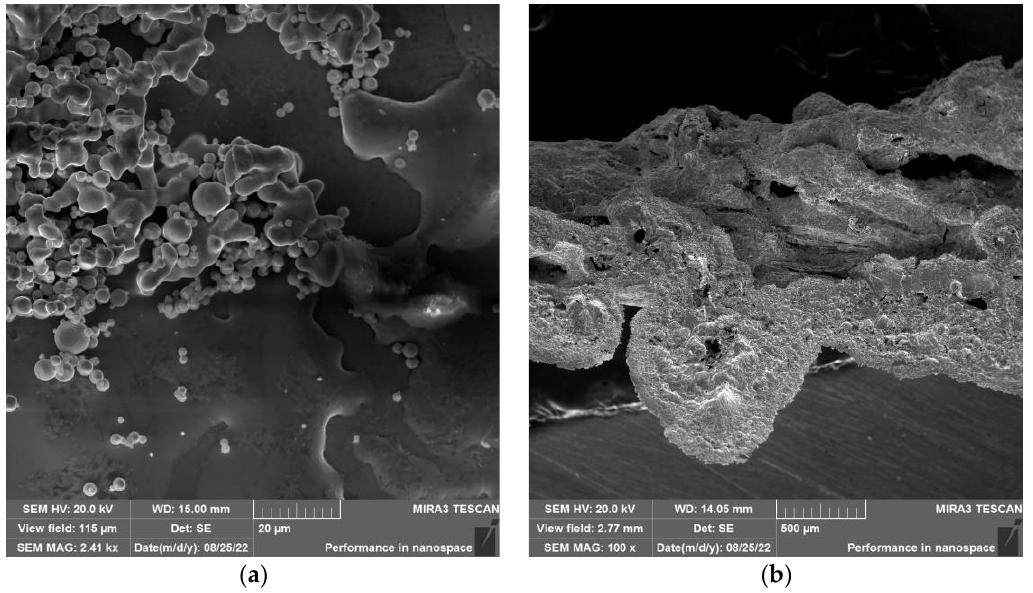
Figure 13. Morphology of ( a ) zinc drop product and ( b ) the residue after evaporation by 800 °C. The result of SEM analysis of the zinc product is shown in Figure 13a, where the individual and connected spherical particles can be observed. The result of EDX analysis of these samples is shown in Figure 14 ((a) zinc drop, (b) residue).